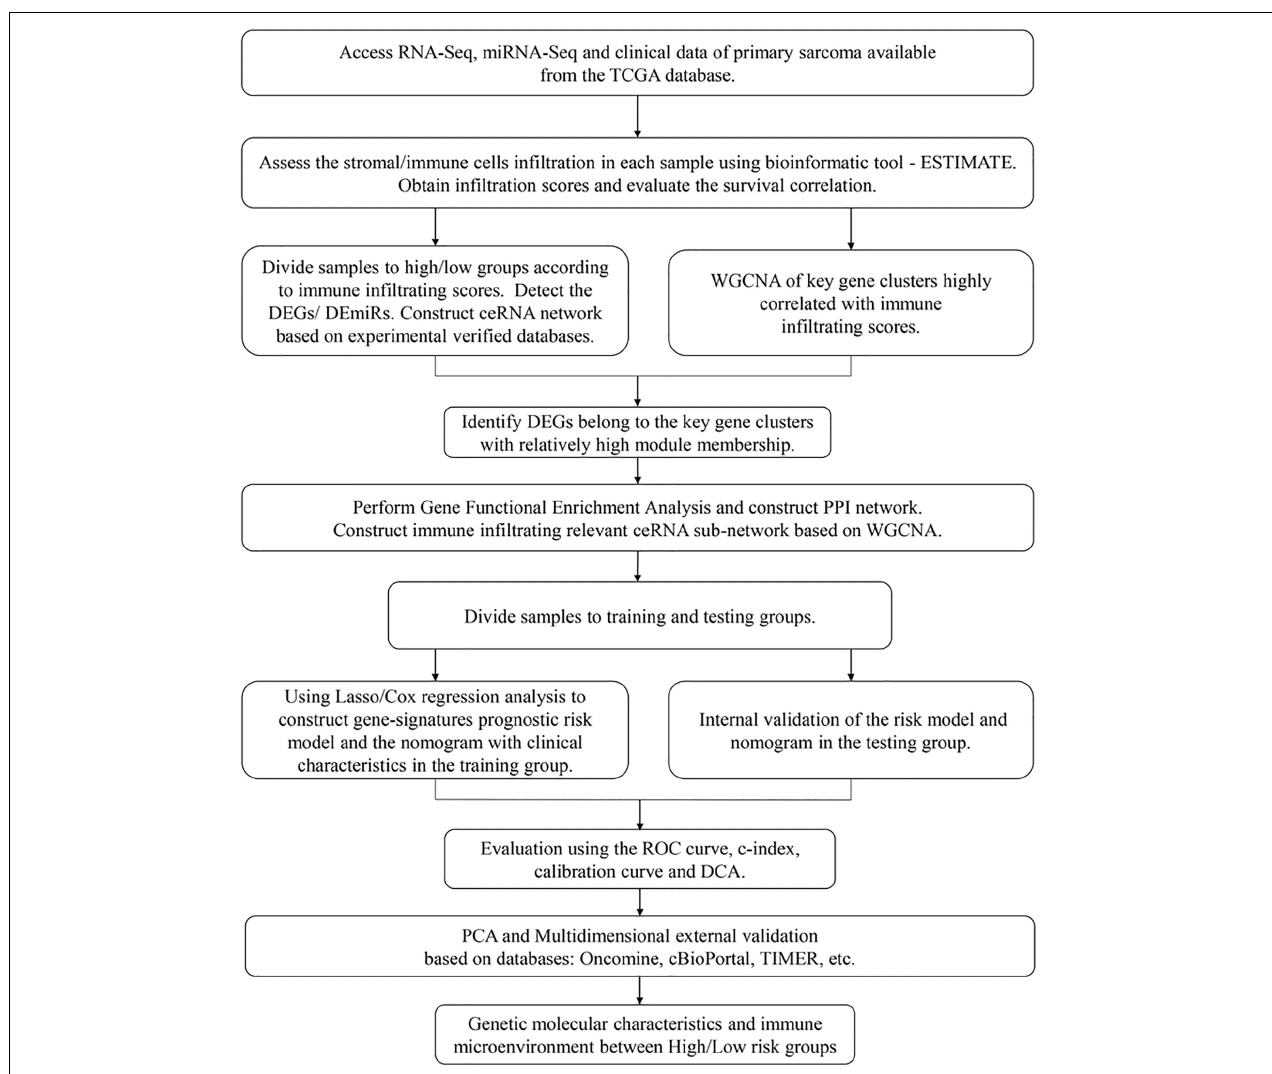
FIGURE 1 | A flowchart for the process of the present